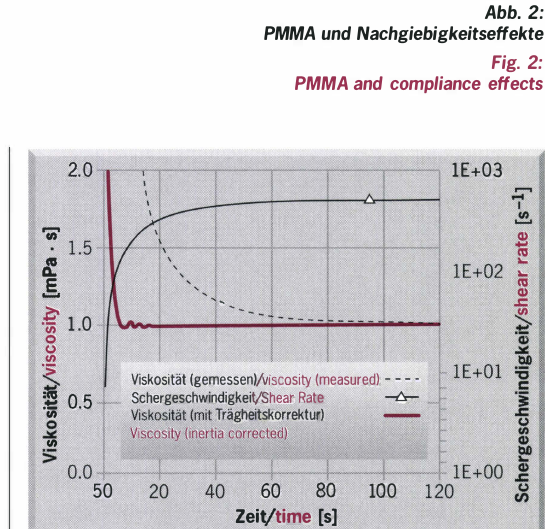
PMMA and compliance effects